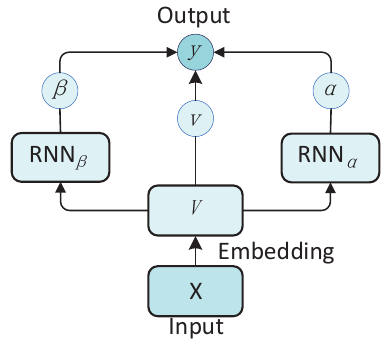
Figure 5. Uncertainty-aware Attention (UA) model structure. RNN α generates the attention α and RNN β generates the attention β . The output y is a combination of embedding V , attention α and attention β